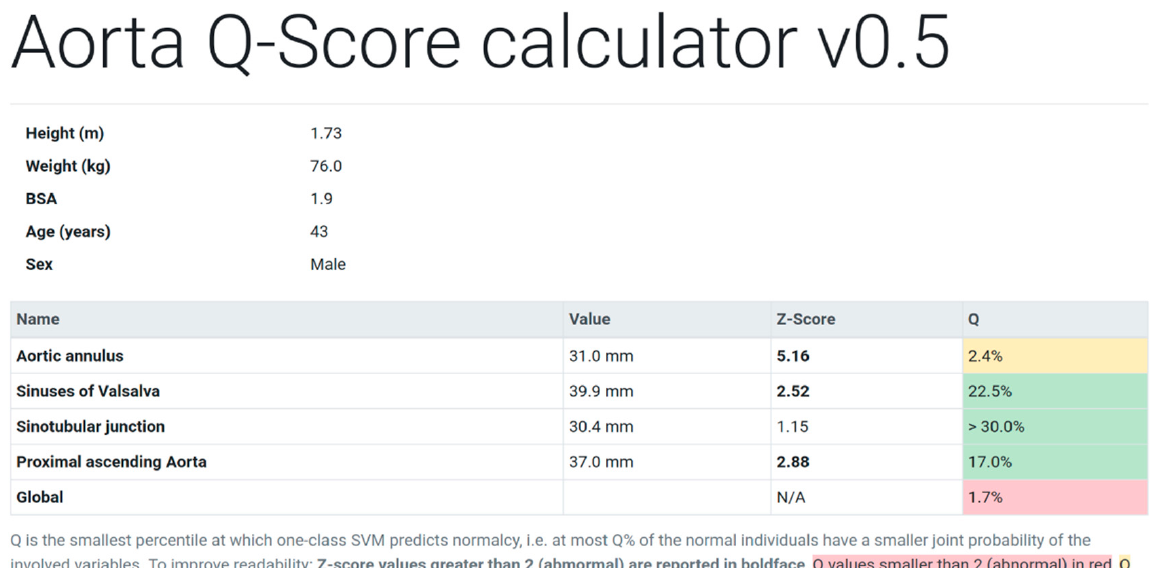
Figure 4. Outputs of both Z-score and Q-score in one patient. Representative output using the web calculator in a 43 year-old male with mildly steno-insufficient bicuspid aortic valve. The first two columns report the different aortic levels and their respective size in mm. The third column reports results of the Z-score for each aortic level, while the last one provides the regional and global Q-scores. Z-score values greater than 2 (abnormal) are in bold. Q-score values smaller than 2% (abnormal) are highlighted in red, while values between 2% and 4% (borderline) are colored in yellow. Q-values greater than 4% (normal) are in green. Table 4. AUC for models trained on the overall population, and only on subjects aged >15